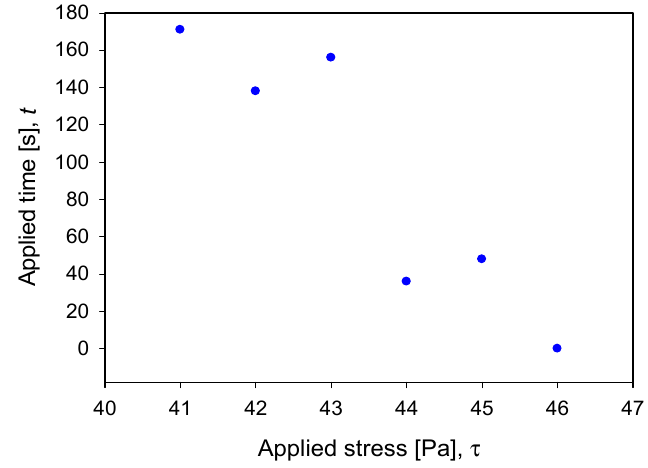
Figure 9. Relationship between yield stress and applied time for quartz slurries at pH 10.7.